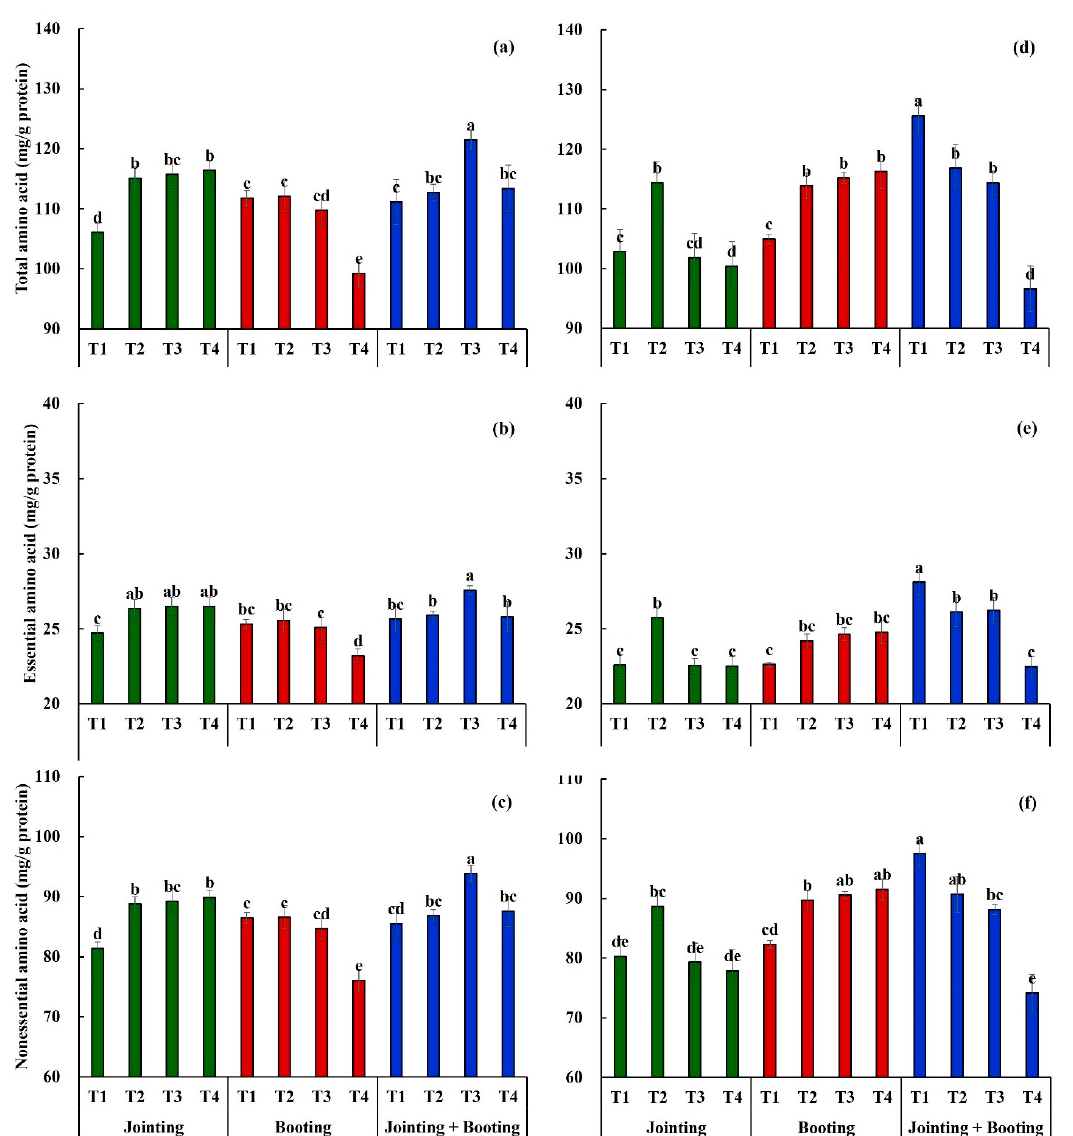
Figure 3. The contents of total amino acids, essential amino acids, and nonessential amino acids of Yangmai16 ( a – c ) and Xumai30 ( d – f ) under different low-temperature treatments. Vertical bars represent the standard deviation of the mean. Different lowercase letters indicate significant differences at the 0.05 level.